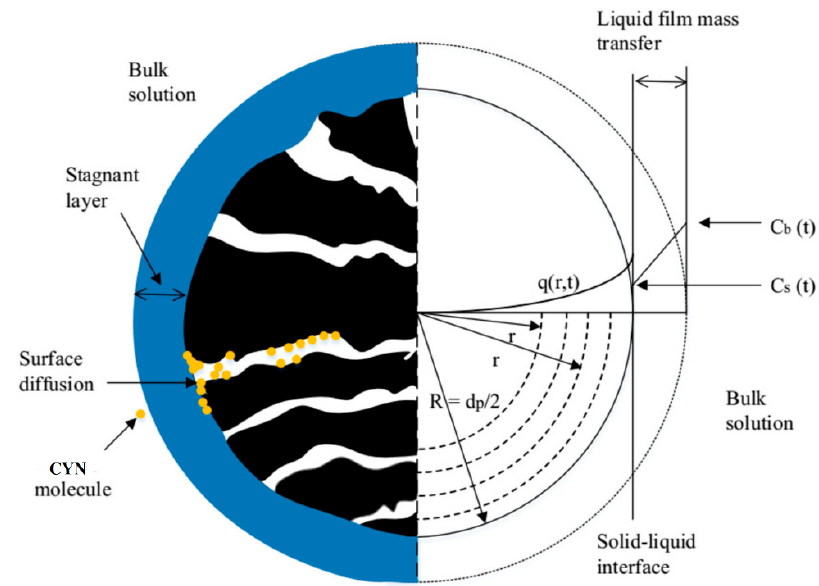
Figure 4. Illustration of the mass transfer–adsorption process into a particle of GAC.